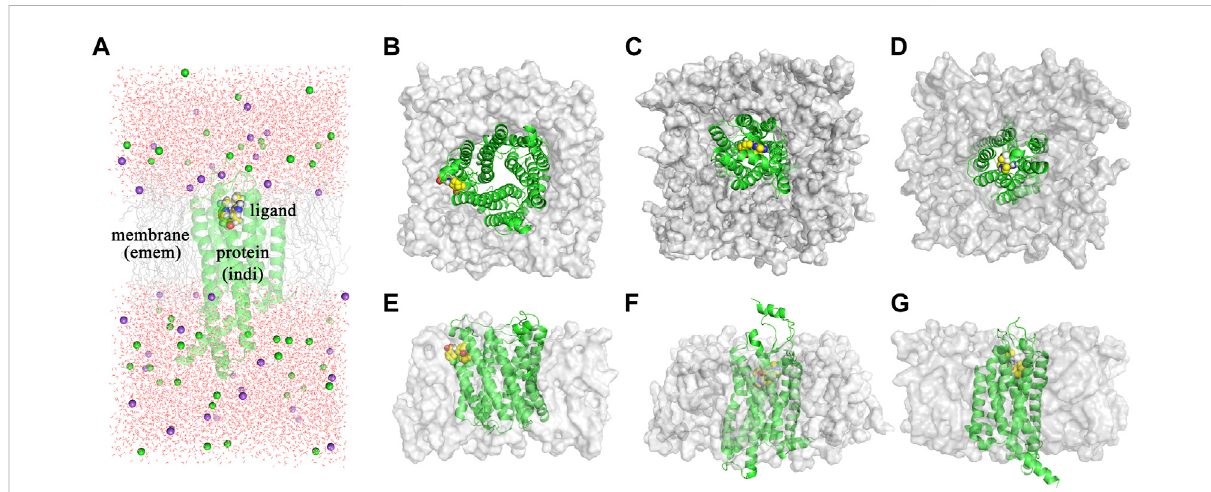
FIGURE 3 (A) The dielectric regions in GPBAR systems. (B) The complex structure of mPGES protein and its ligand. (C) The complex structure of OX1proteinanditsligand. (D) The complexstructureofGPBARproteinanditsligand. (E) The sideviewofthemPGEScomplexstructure. (F) Theside view of the OX1 complex structure. (G) The side view of the GPBAR complex